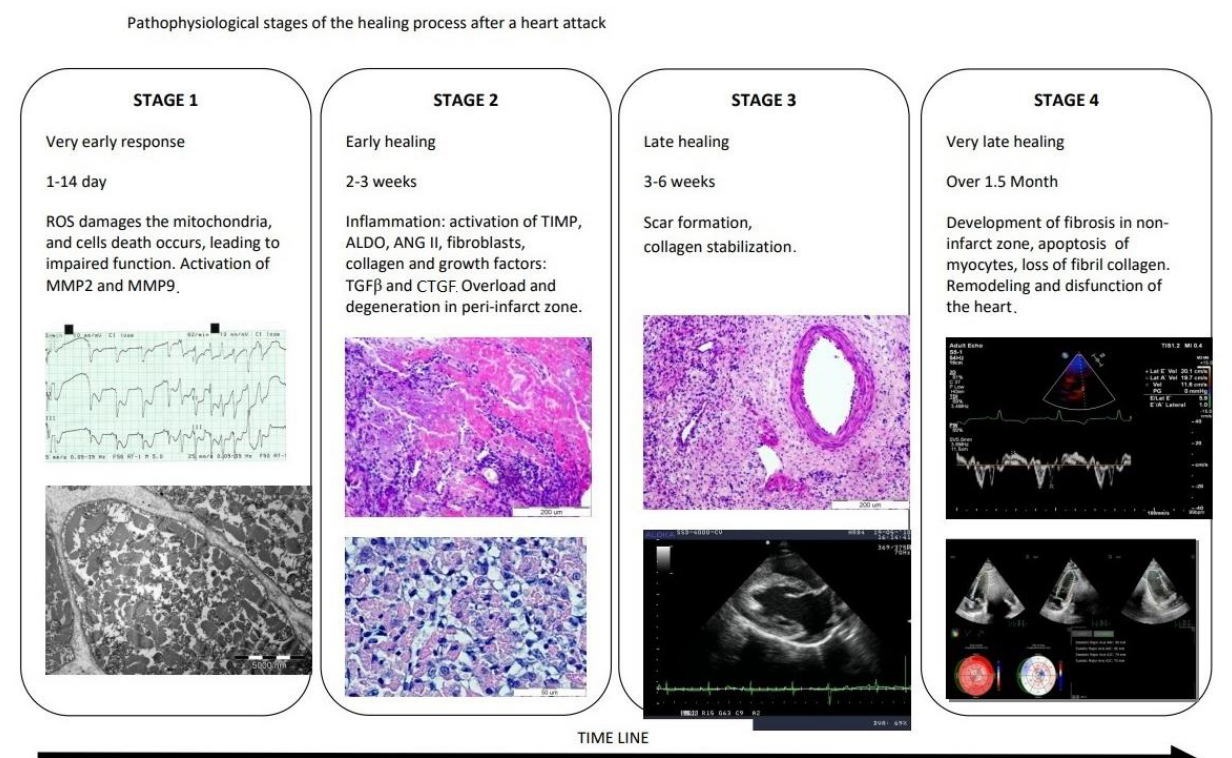
Figure 1. Pathophysiological stages of the healing process after a myocardial infarction. ROS—reactive oxygen species, MMP2—metalloproteinase-2, MMP9—metalloproteinase-9, TIMP—tissue inhibitors of matrix metalloproteinase, ALDO—aldosterone, ANGII—angiotensin II, TGF- β —transforming growth factor beta, CTGF — connective tissue growth factor.